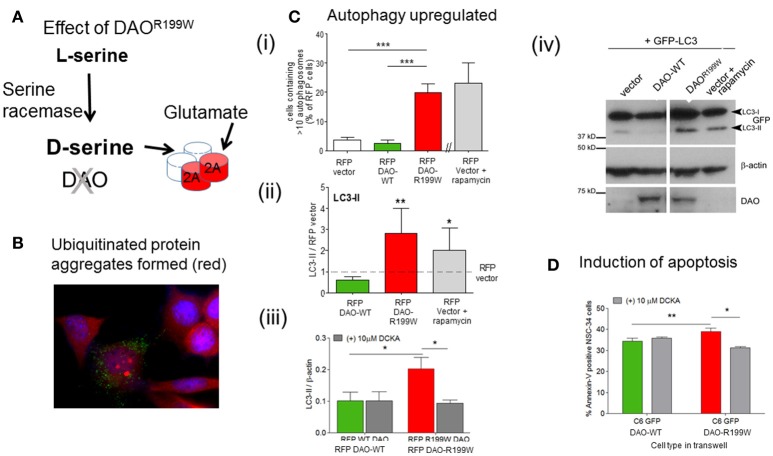
Pathogenic processes caused by FALS-associated mutation DAOR199W. (A) Model showing the potential effects of DAOR199W. (B) Effect of DAOR199W on ubiquitin aggregates. NSC-34 cells expressing GFP-tagged DAO 72 h after transfection. Ubiquitin (UBQ) staining (red) with aggregates in GFP-positive cells are shown in a merged image with DAPI nuclear staining. Data taken from Mitchell et al. (2010). (C) DAOR199W promotes autophagy. (i) NSC-34 cells were co-transfected with RFP-tagged D-amino acid oxidase (DAO) and GFP-tagged protein light chain 3 (LC3). The number of vector or DAO transfected cells containing more than 10 GFP-LC3 puncta or autophagosomes were quantified. (ii) Quantification of LC3 (I and II) using Western blot analysis. Rapamycin induced autophagy was used as a positive control. Levels of LC3-II protein were calculated using densitometry and normalized to protein levels of RFP-vector. (iii) NSC-34 cells were treated with 5,7-dichloro-4-hydroxyquinoline-2-carboxylic acid (DCKA), immunoblotted and quantified. Significant 1-way ANOVA with Friedman's test subject to post hoc testing with Dunn's multiple comparison test or 2-way analysis of variance (ANOVA). Values are means ±SEM for 4–6 experiments, for p values, *p < 0.05; **p < 0.01; ***p < 0.001. The images shows RFP-DAO (red), ubiquitin (green), and DAPI nuclear stain (blue). DAPI, 4′,6-diamidino-2-phenylindole. Data taken from Paul et al. (2014) with permission from Elsevier. (iv) A representative western blot is shown. (D) DAOR199W promotes apoptosis in neuronal cells. Annexin V levels in NSC-34 neuronal cells co-cultured with C6 glial cells permanently expressing wild-type (WT) or DAOR199W, treated with vector or 5,7-dichloro-4-hydroxyquinoline-2-carboxylic acid (DCKA). Paired t-test used. Values are means ± standard error of the mean, for 3 experiments with p-values shown, *p < 0.05, **p < 0.01. Data taken from Paul et al. (2014) with permission from Elsevier.